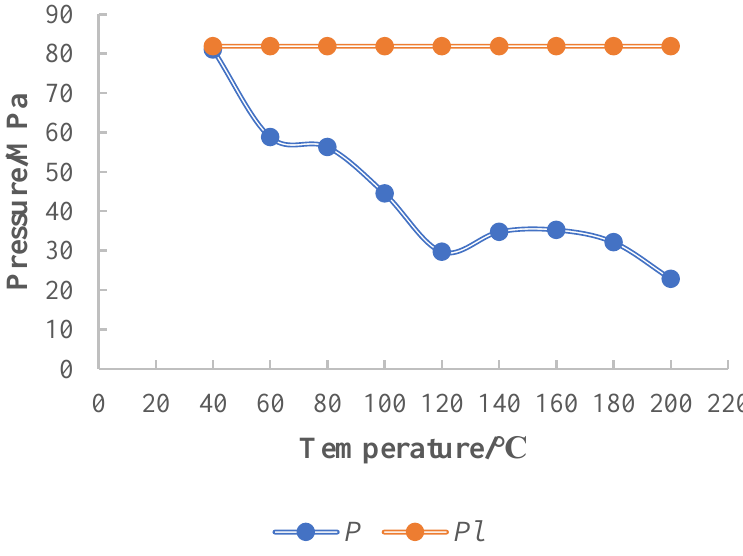
Figure 8. Densification pressure versus temperature.